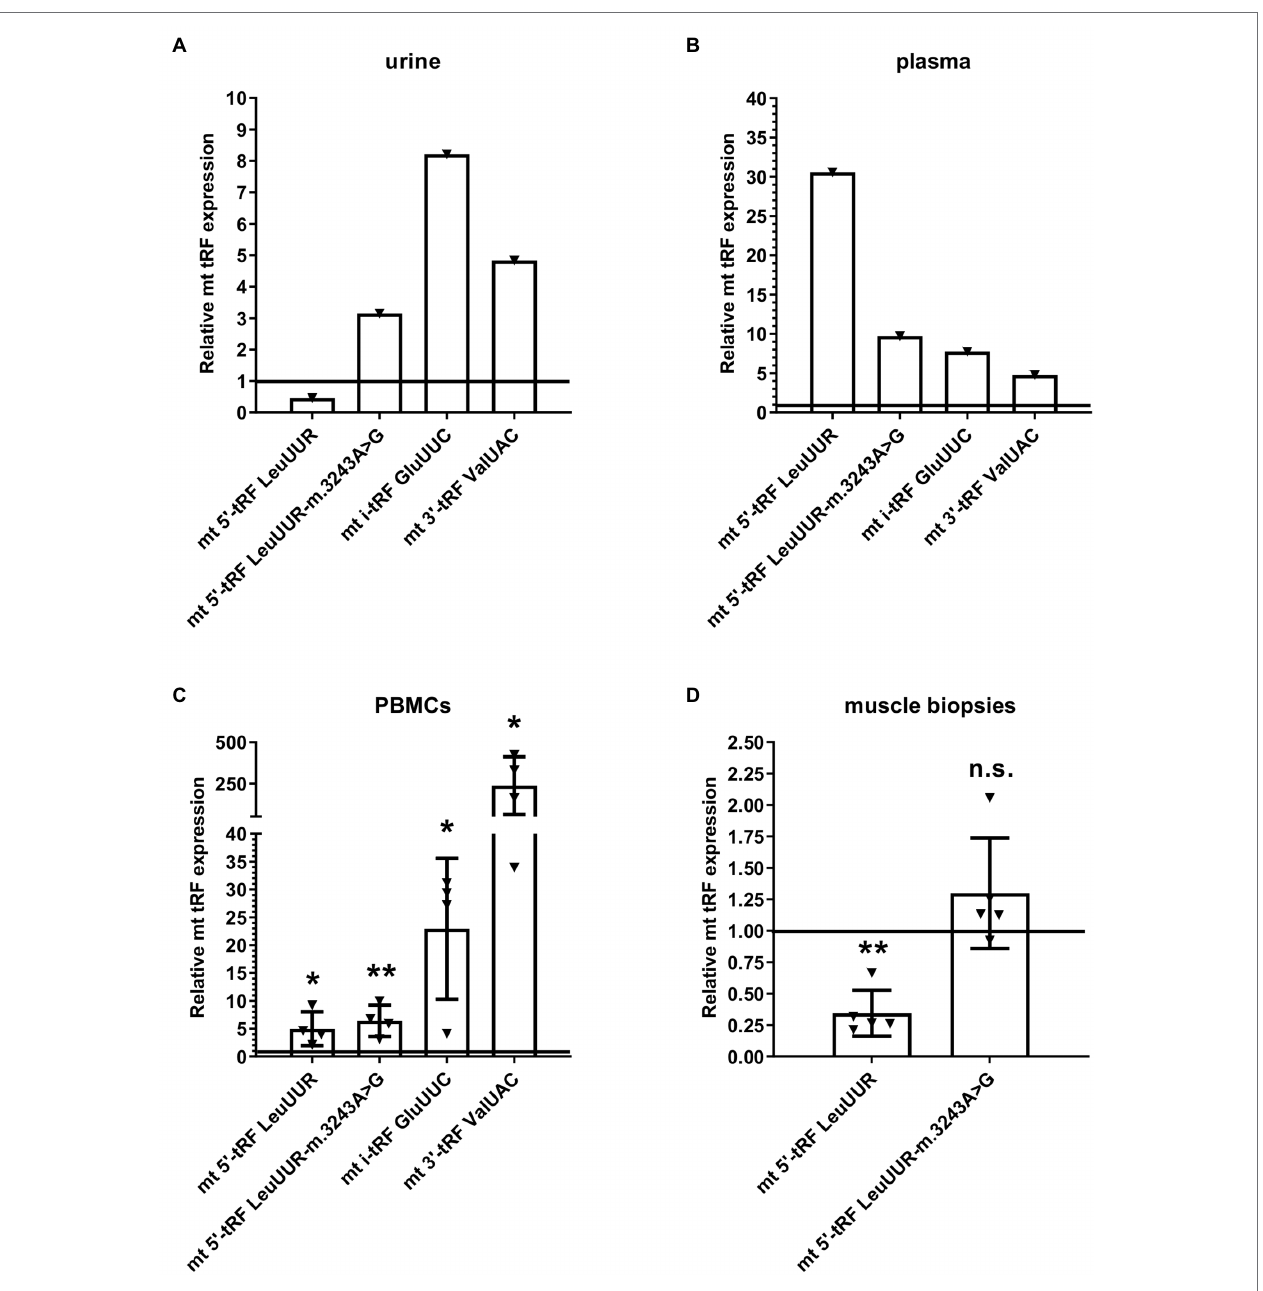
FIGURE 4 | Expression profile of mt 5 ′ -tRF LeuUUR, mt 5 ′ -tRF LeuUUR-m.3243A>G, mt i-tRF GluUUC, and mt 3 ′ -tRF ValUAC in a small cohort of diverse samples from MELAS patients and controls. RT-qPCR analysis of the expression of mt 5 ′ -tRF LeuUUR, mt 5 ′ -tRF LeuUUR-m.3243A>G, mt i-tRF GluUUC and mt 3 ′ -tRF ValUAC in biofluids (urine and plasma), PBMCs, and muscle tissues from MELAS patients as compared to controls. Data are represented as fold change respect to values from control samples. Each triangle represents an individual and the horizontal bar the media value for control group. Differences from control values were found to be statistically significant at * p < 0.05 and ** p <